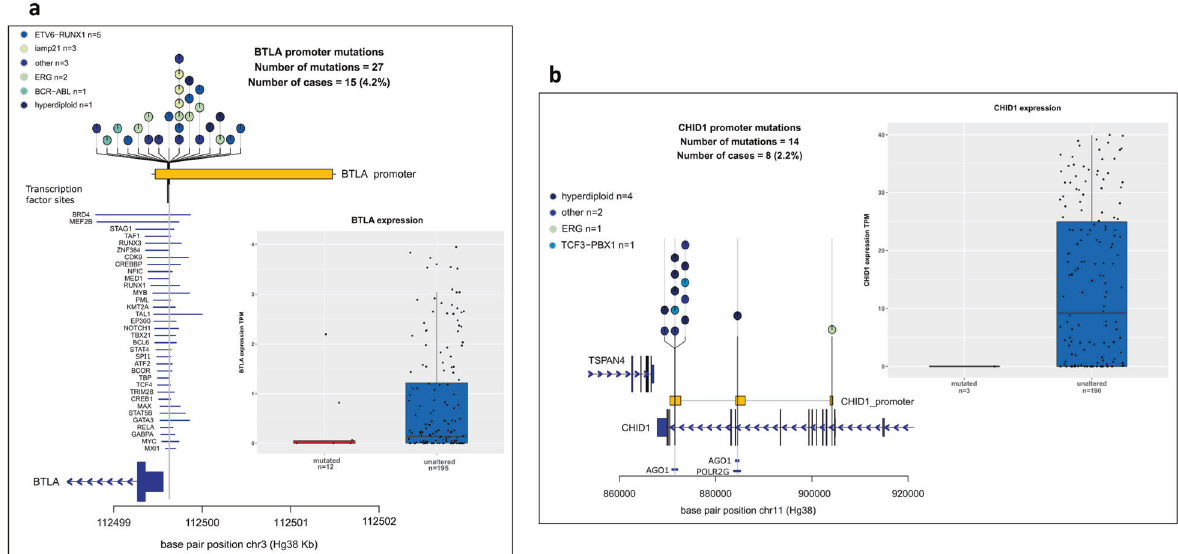
Fig. 4 Non-coding driver mutations. Mutation burden within promoters and their transcriptional impact. Promoter mutations of ( a ) BTLA and ( b ) CHID1 . Regional plot of mutations (coloured circles) relative to coding sequence (dark blue boxes) and promoter (yellow horizontal bar). Transcription factor binding sites (light blue horizontal line) overlapping mutations were extracted from Encode and ChIP atlas. Grey boxes correspond to transcriptional impact on respective gene. Box and whiskers plot, tumours are split by mutational status, dots represent individual